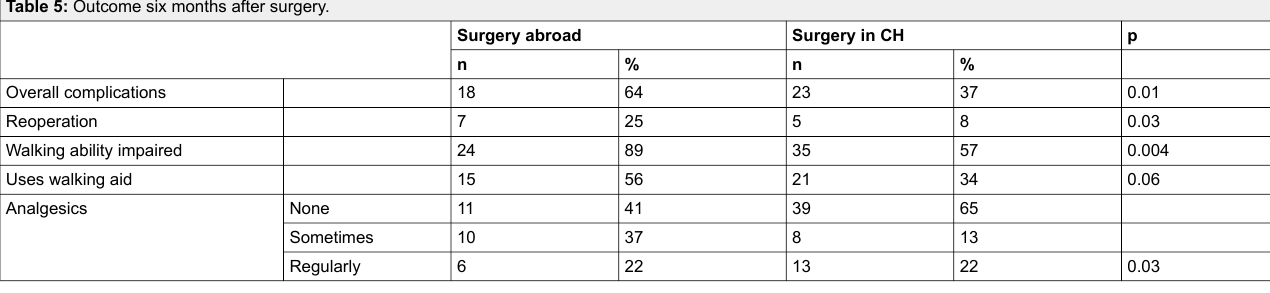
Table 5: Outcome six months after surgery.